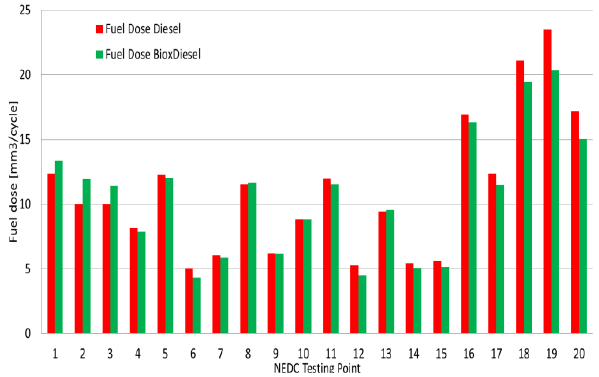
Fig. 4. Comparison of the fuel dose for the engine fed with Bioxdiesel and Diesel fuel for selected operation points according to NEDC procedure